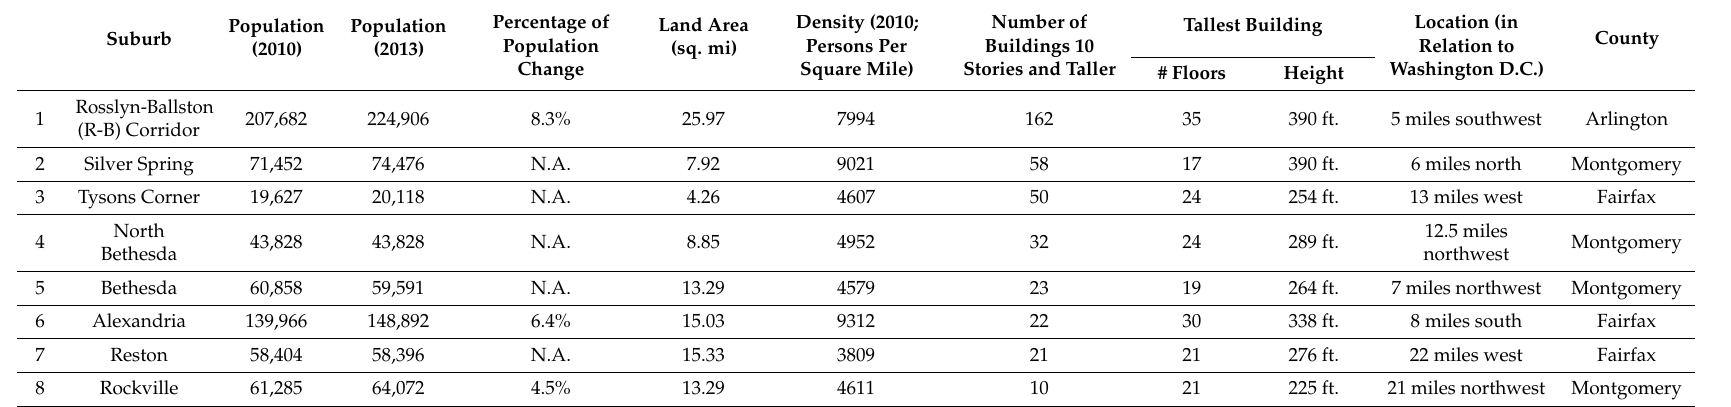
Table 2. Summary of the spatial profile of the examined suburban communities in the Washington, D.C. region